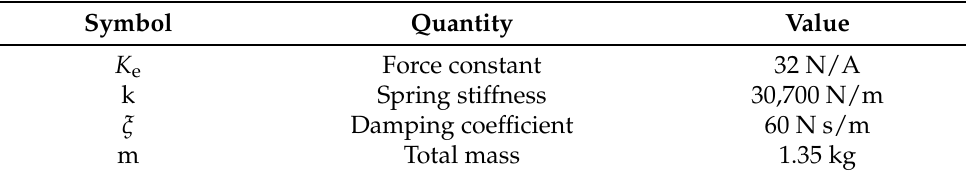
Table 1. Parameters of PMLOSM.